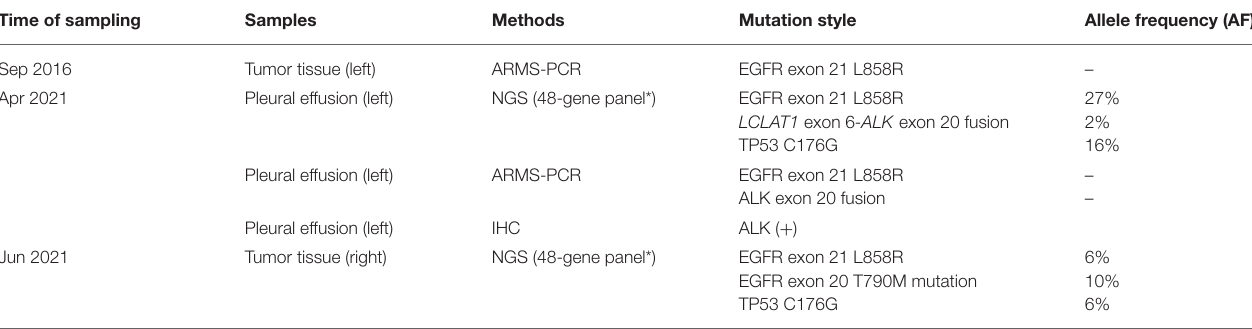
TABLE 1 | Molecular detection during treatment of the patient in the